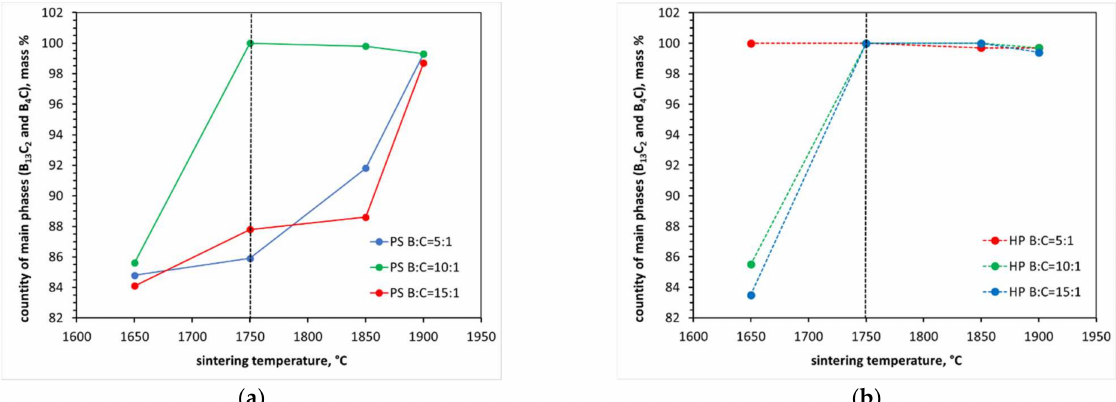
Figure 11. Measurement results of quantitative phase composition including stable boron carbide structures, i.e., B 13 C 2 and B 4 C, as a function of reaction sintering temperature and sintering method used: PS, pressureless sintering ( a ); HP, hot pressing ( b